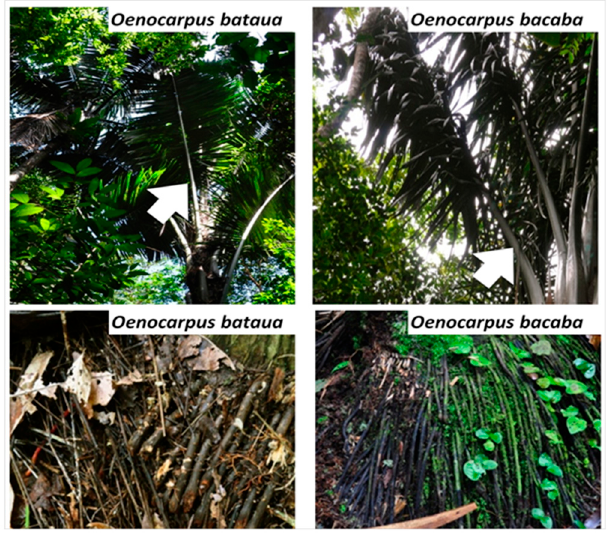
Figure 1. Organs collected from Oenocarpus bataua and Oenocarpus bacaba in French Guiana. Upper panel show the leaves selected for leaflets collection (white arrow); Lower panel show roots selected for collection.